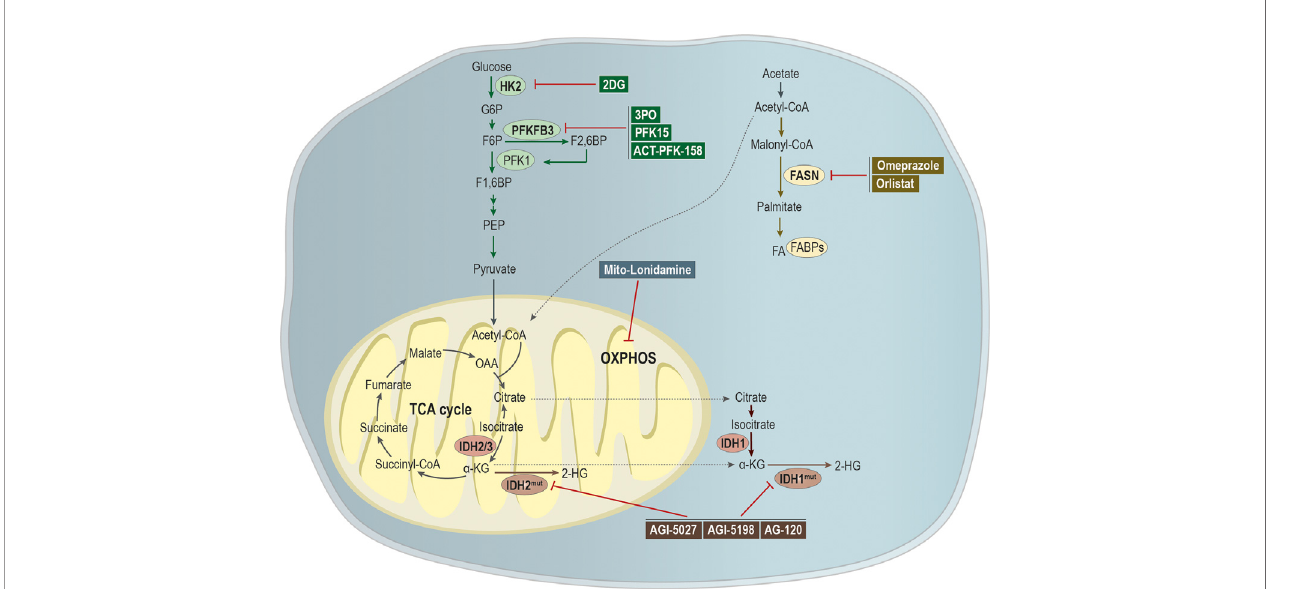
FIGURE 3 | Targeting metabolic pathways as a putative strategy to tackle metastatic cancer. Glycolytic inhibitors have been shown as being a promising application for the treatment of metastatic cancer. The compound 2-deoxy- D -glucose (2-DG) acts as an inhibitor of hexokinase 2 (HK-2), while 3PO, 1-(4-pyridinyl)-3-(2- quinolinyl)-2-propen-1-one (PFK15) and ACT-PFK-158 were designed to inhibit the activity of PFKFB3. A modi fi ed version of lonidamine was developed to inhibit OXPHOS and mitochondrial bioenergetics. Mutations in isocitrate dehydrogenases 1/2 (IDH 1/2) leads to the generation of the oncometabolite 2-hydroxyglutarate (2-HG), being the development of IDH mut inhibitors, as AGI-5027, AGI-5198, and AG-120, an attempt to abrogate 2-HG production. Moreover, omeprazole and orlistat, inhibitors of fatty acid synthase (FASN), showed a promising clinical applicability in the treatment of metastatic